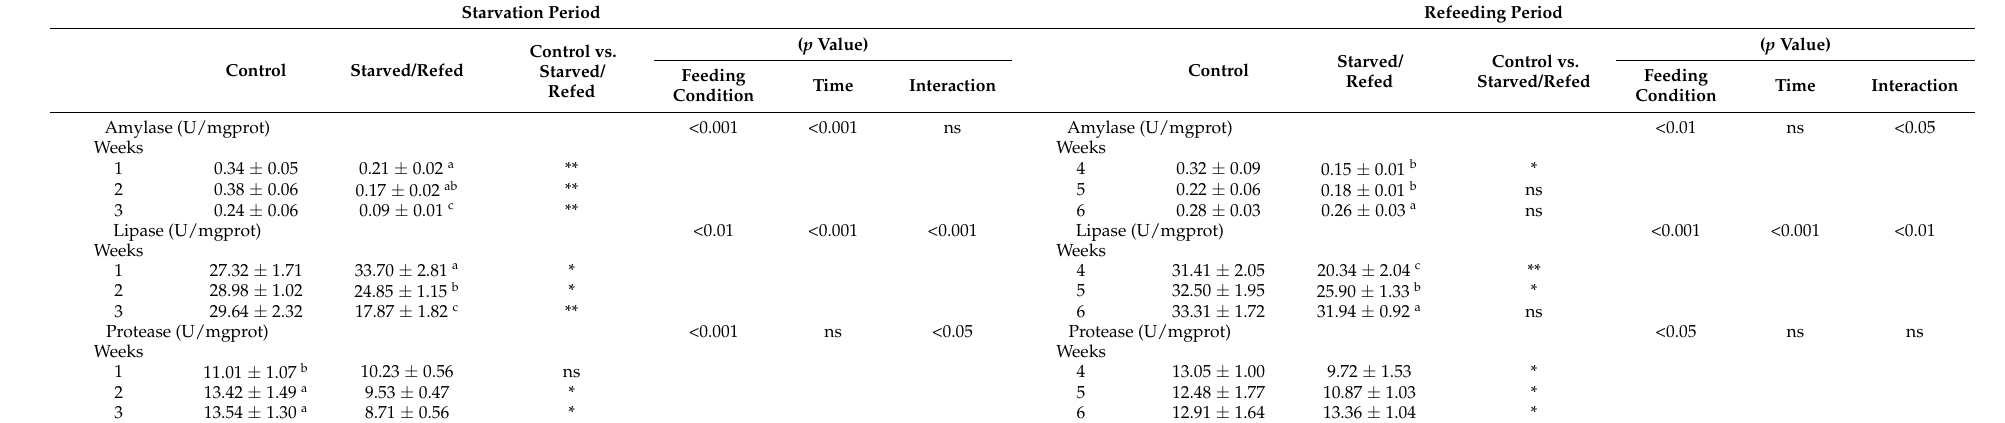
Table 5. Intestinal digestive enzyme activities of O. macrolepis exposed to starvation and refeeding periods.